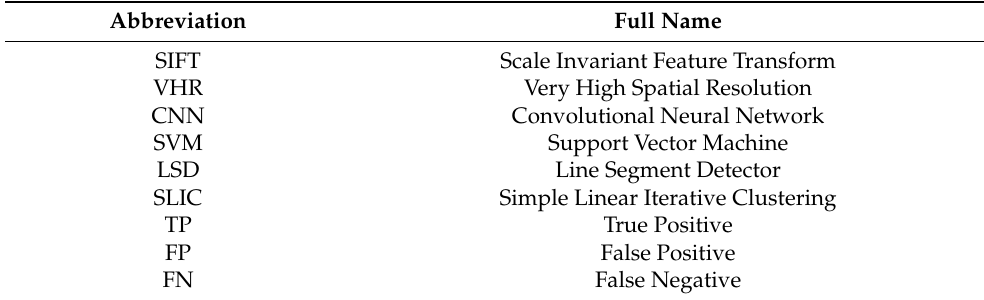
Table A1. All the acronyms used in this